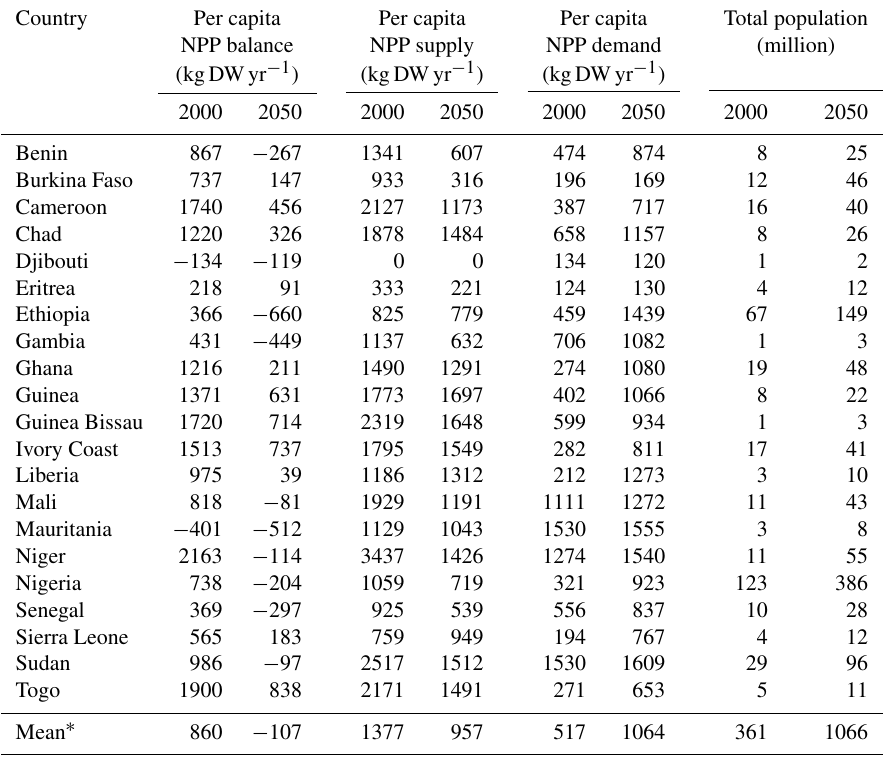
Table 4. Per capita NPP balance, NPP supply, NPP demand, and population for SSP2–RCP6 for 2000 and 2050. NPP is given in dry weight